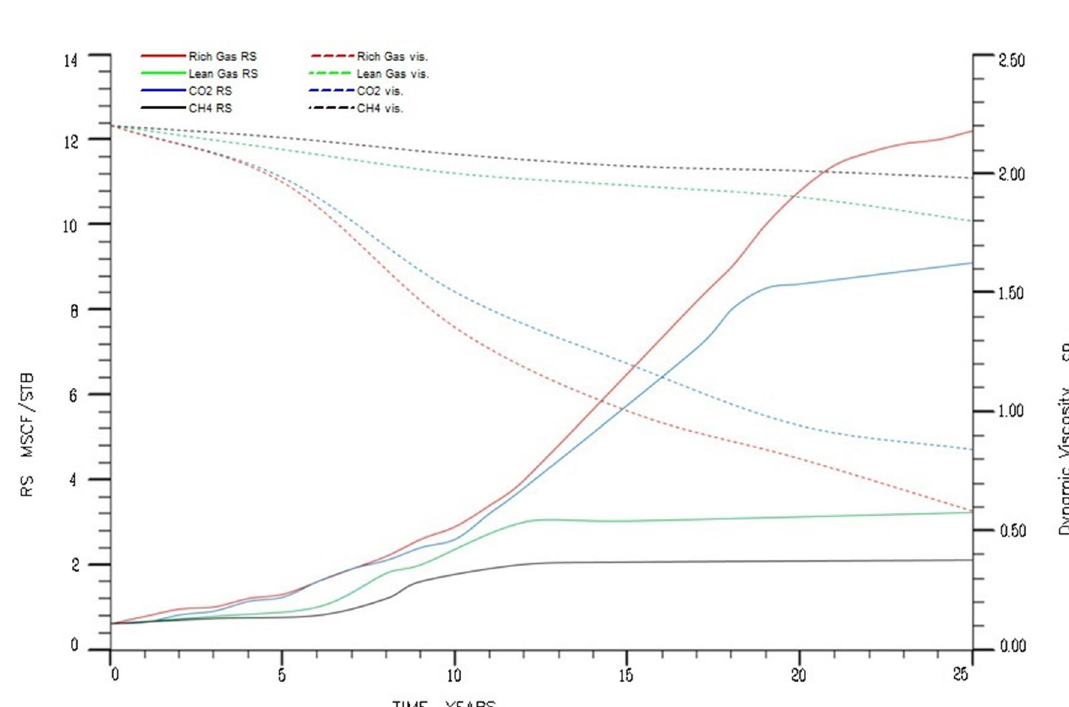
Fig. 8 Variation in reservoir fluid viscosity and gas–oil ratio during injection of different gases at one